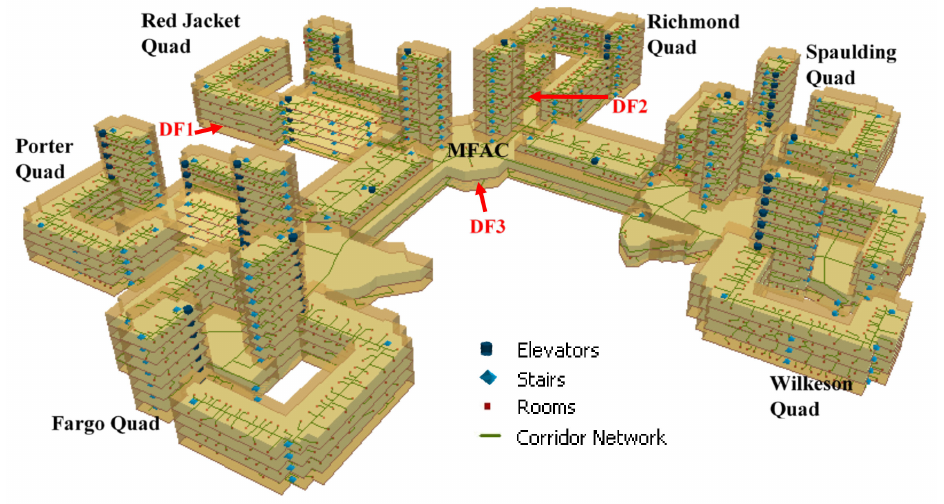
Figure 15. 2.5D model of the Ellicott complex and its dining